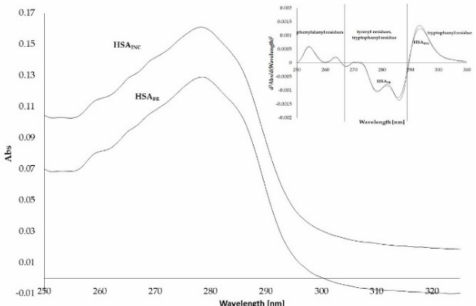
Figure 2. Absorption spectra of unmodified human serum albumin (HSA FR ) and incubated human serum albumin (HSA INC ) at 5 × 10 − 6 mol · L − 1 concentration. In the insert: second derivative of 5 × 10 − 6 mol · L − 1 HSA FR and HSA INC absorption